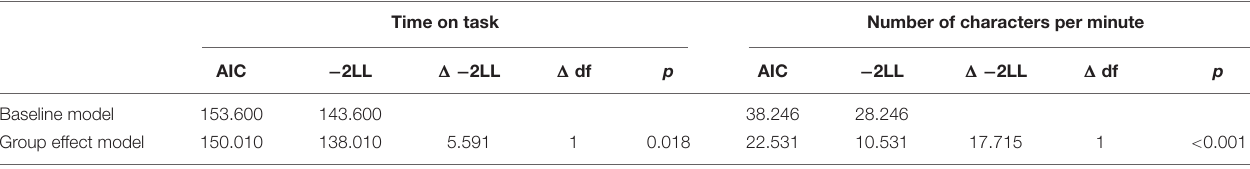
TABLE 3 | Comparison of the baseline and the group effect models for time on task and number of characters per minute.